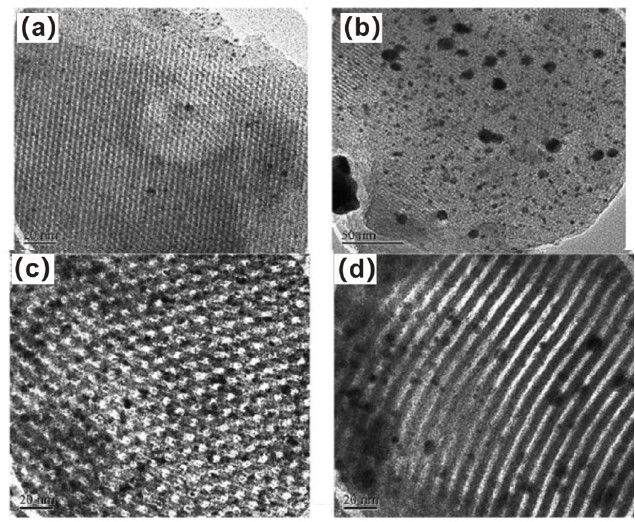
Figure 7. TEM of ( a and b ) MCM-48 and ( c and d ) SBA-15 modified with APTS, then − adsorbed, reduction by NaBH AuCl , uncalcined and calcined at 560 °C, respectively. 4 4 Reproduced with permission from [36]. Copyright 2005 Elsevier